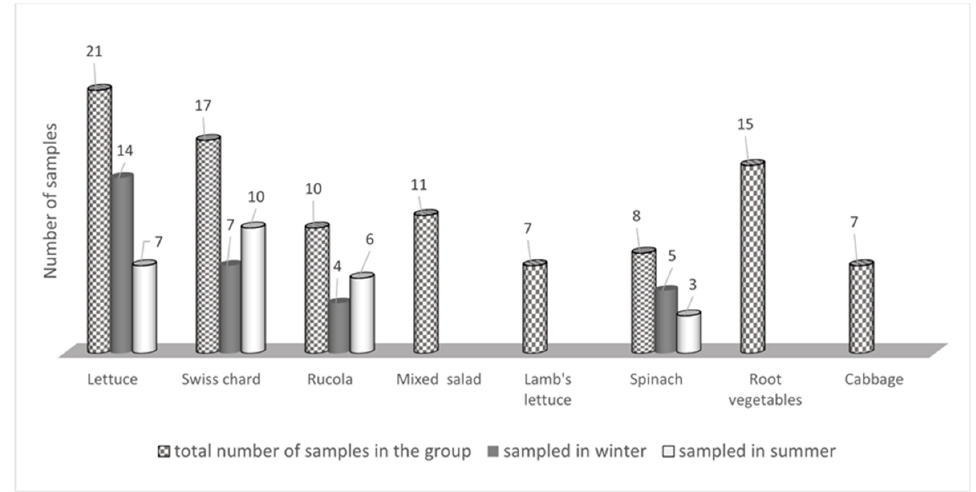
Figure 2. Distribution of the samples in the study, including the total number of samples within the group and the distribution by seasons.